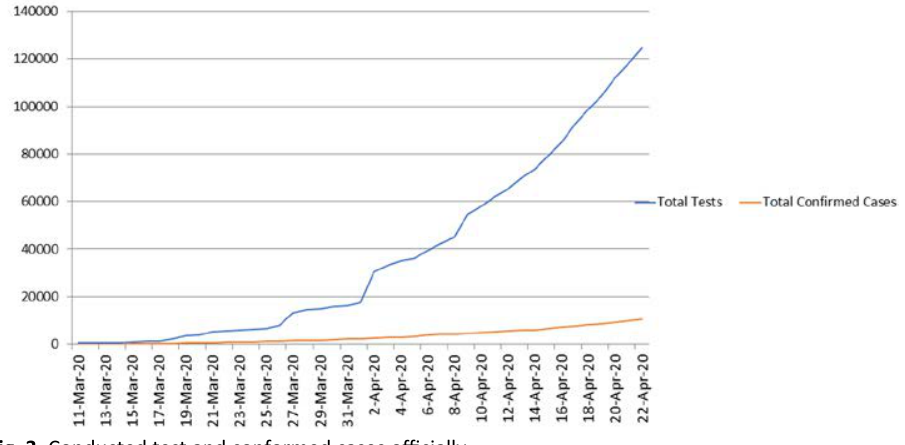
Fig. 3. Conducted test and conformed cases